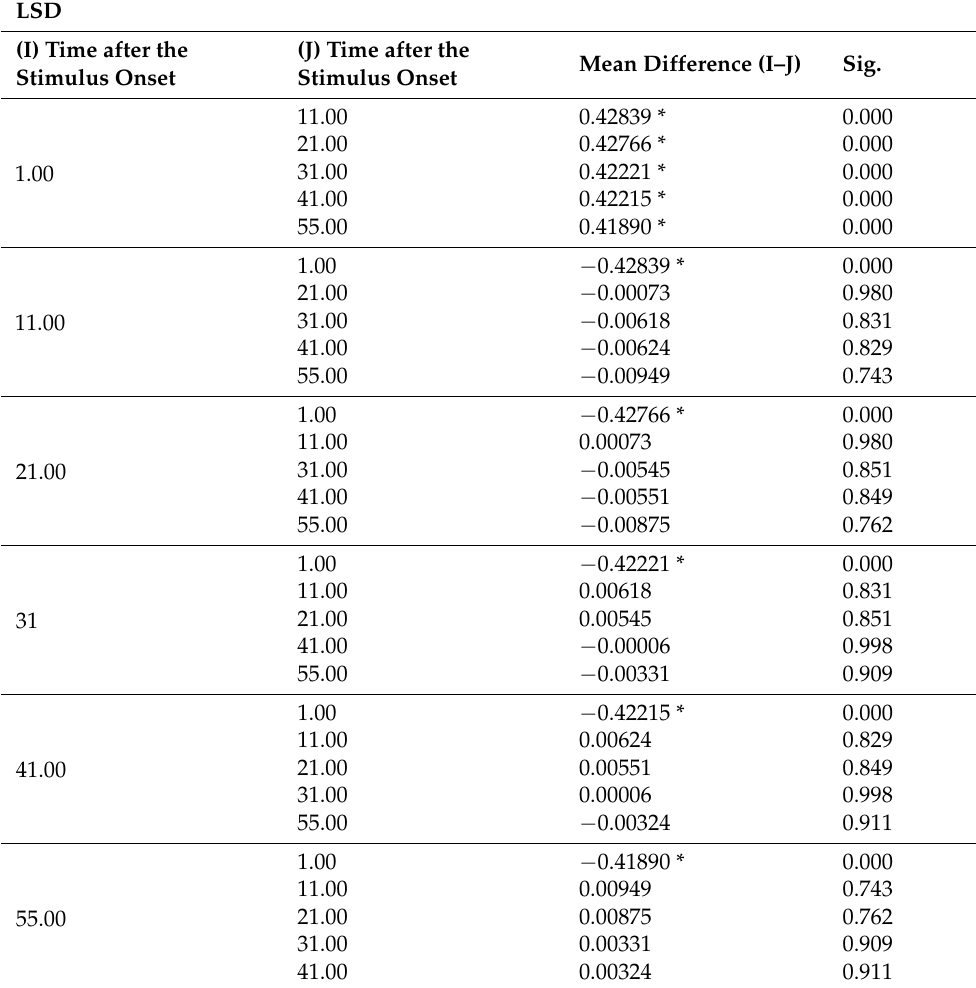
Table 3. Paired comparisons of RPDs at different times after stimuli presentation (the luminance of red stimuli is 366 cd/m 2 ). Dependent factor: Relative pupil